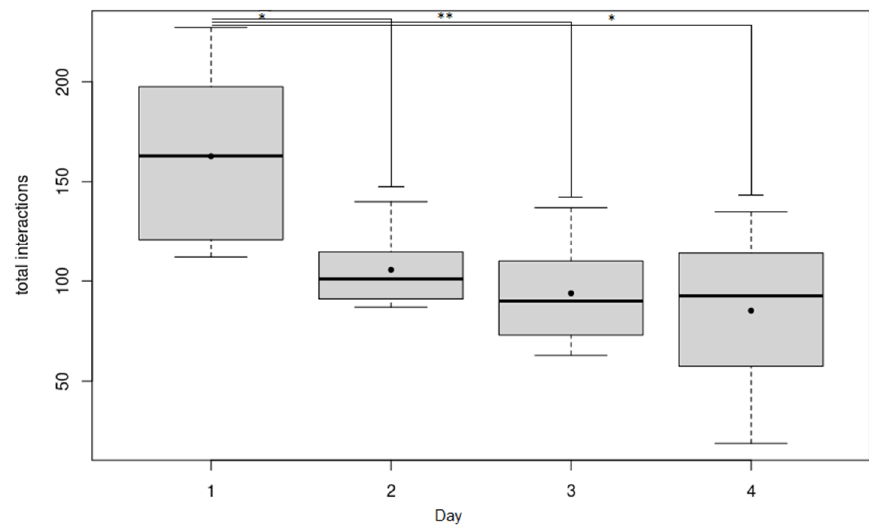
Figure 3. “Total interactions before being housed in social box”. Boxplot of the total interactions recorded during the different days, before being housed in the social box. The horizontal line shows the median, the box extends from the lower to the upper quartile, and the whiskers to 1.5 × the interquartile range above the upper quartile or below the lower quartile. The black dots indicate the mean. Significant differences between treatments are indicated as * p ≤ 0.05, ** p ≤ 0.001.